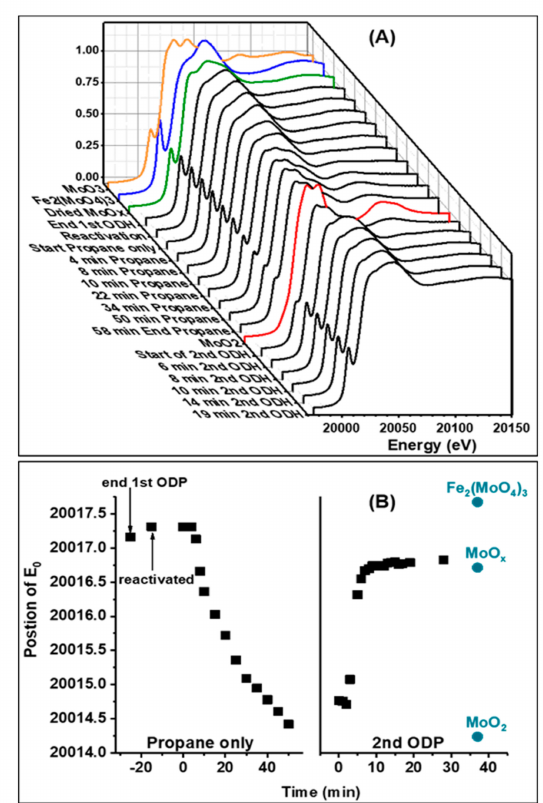
Figure 2. In situ X-ray Absorption Near Edge Structure (XANES) spectra of MoO x / Al 2 O 3 at 500 ◦ C during oxidative and non-oxidative dehydrogenation of propane cycle ( A ) and the change in the position of the edge energy of the XANES during on stream of the reaction cycle ( B ). XANES spectra